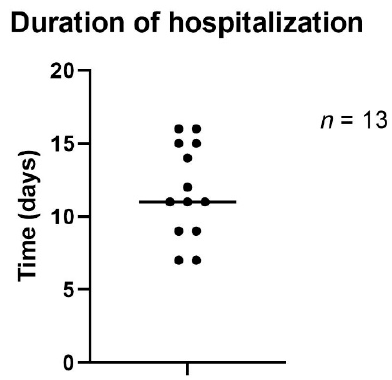
Figure 7. Duration of hospitalization.